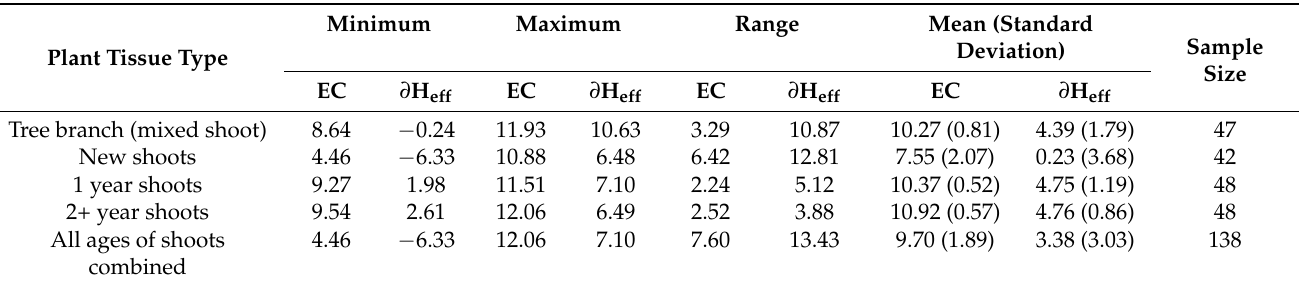
Table 3. Seasonal variation in energy content and flammability. Minimum, maximum, mean,